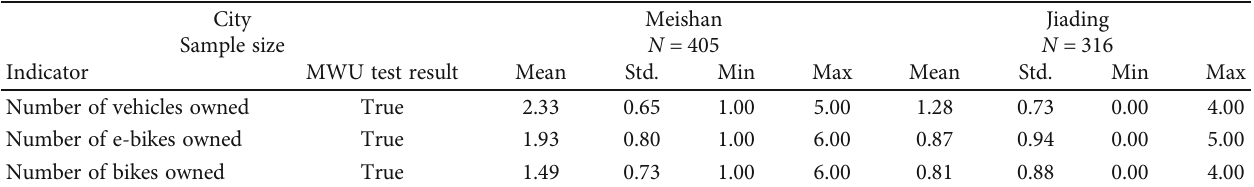
Table 3: Number of vehicles, e-bikes, and bikes owned characteristics of the sample in the two